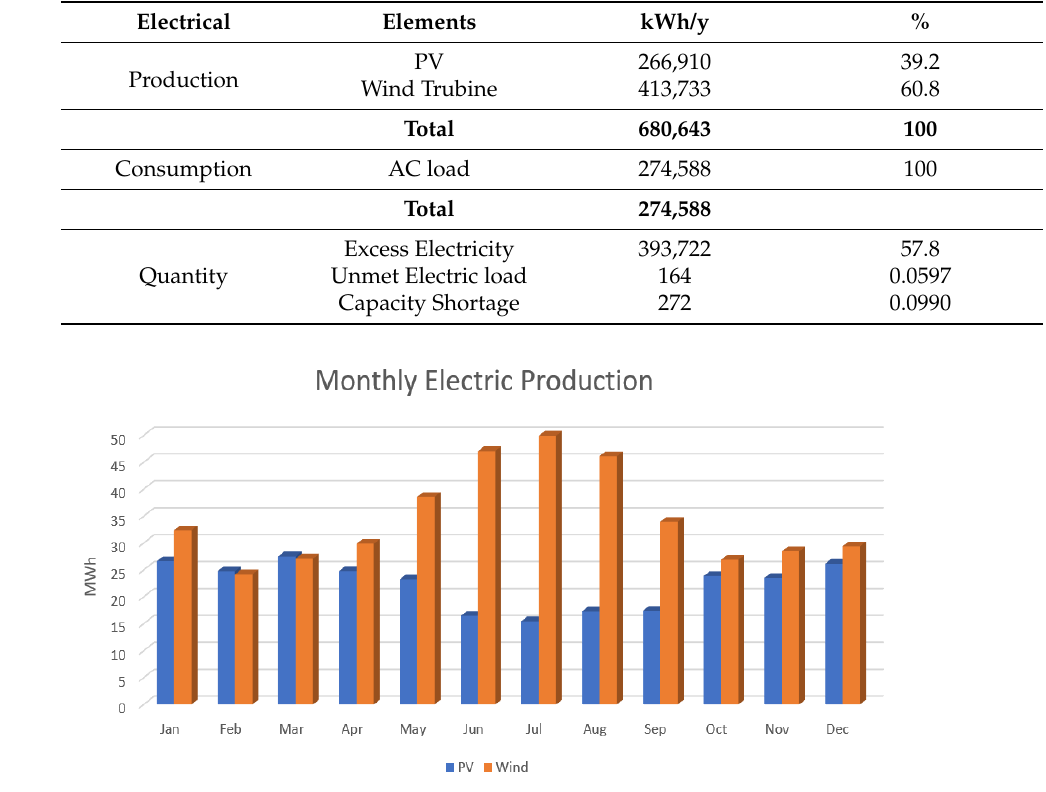
Figure 8. PV/Wind/Battery-based electricity production throughout the year.